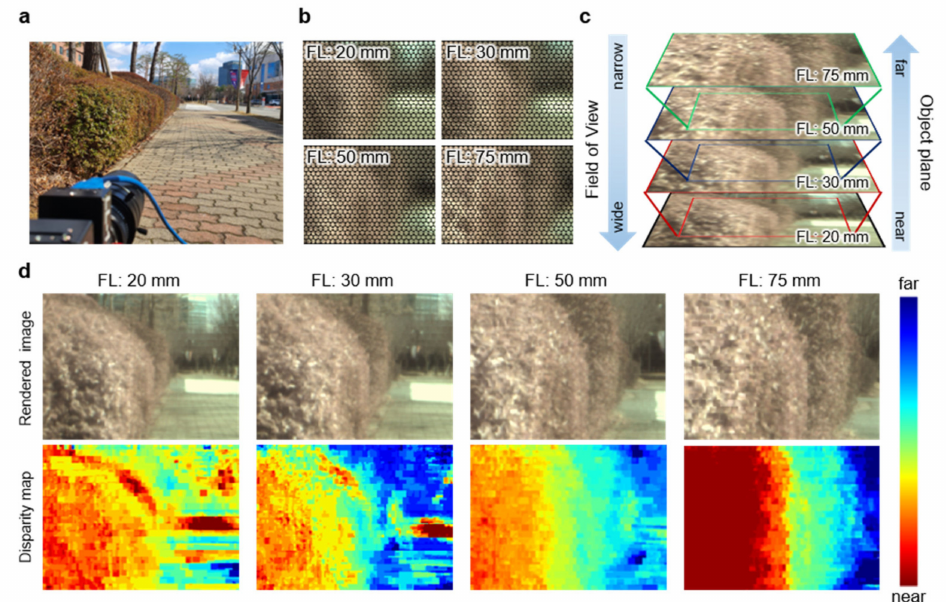
Figure 5. ( a ) Photograph of outdoor measurement setup of VF-LFC. ( b ) Microimages from VF-LFC at four different focal lengths. ( c ) Photographs indicating the field of view difference and object distance for each focal length. ( d ) Photographs after image rendering (top row) and disparity maps according to each focal length captured by a VF-LFC (bottom